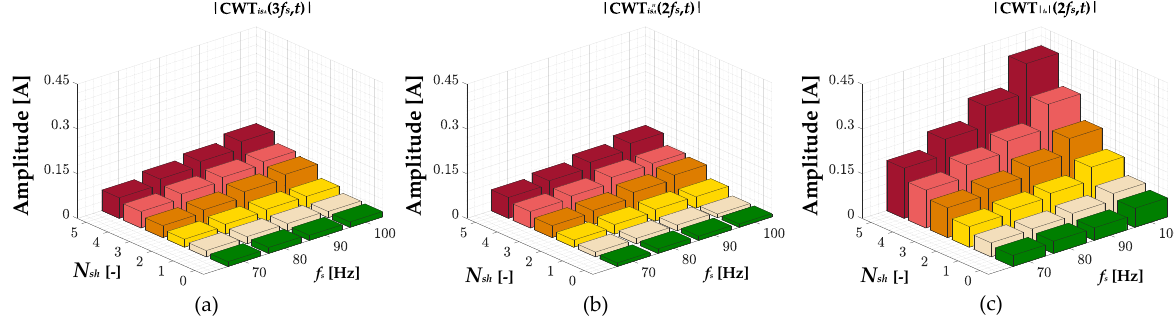
Figure 13. The effect of N sh in the PMSM stator winding and f s value on the amplitude of the extracted symptoms ( a ) |CWT isA (3 f s , t )|, ( b ) |CWT isH A (2 f s , t )| and ( c ) |CWT |isA| (2 f s , t )| ( T L = T N ).